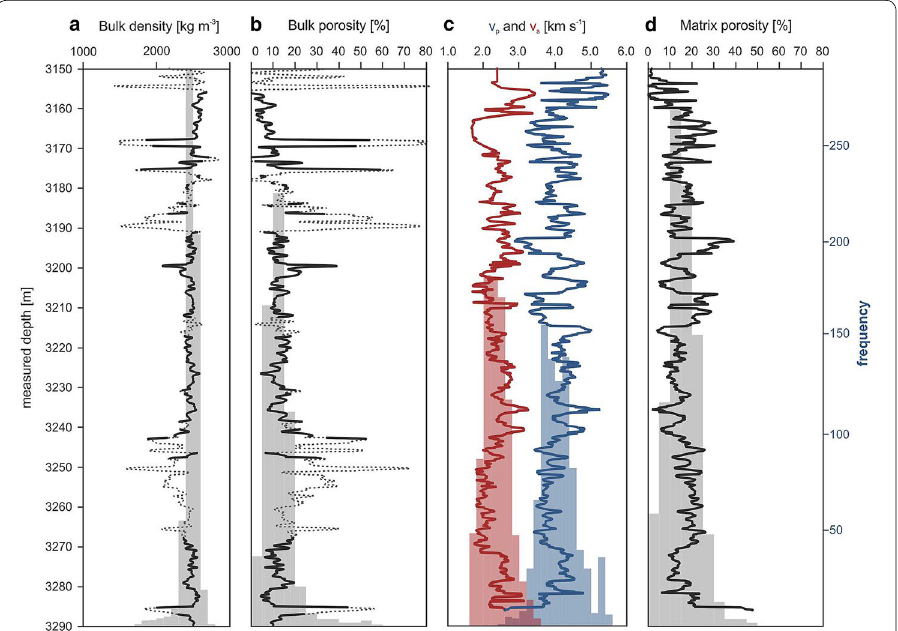
Fig. 11 Vertical bore logs of rock properties and the corresponding histograms. a The bulk density as calcula‑ tion basis for ( b ) the bulk porosity. c The compressional wave velocities (and additionally the shear‑wave velocities) on the basis of calculation for ( d ) the matrix porosity. The grey dotted lines show data rejected